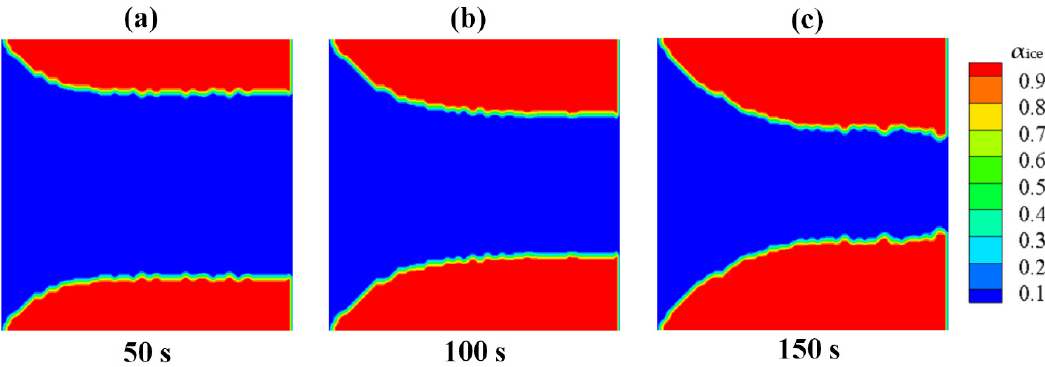
Figure 10. Ice formation and development on the wall boundary with time advancing (case ex) ( a ) 50 s,